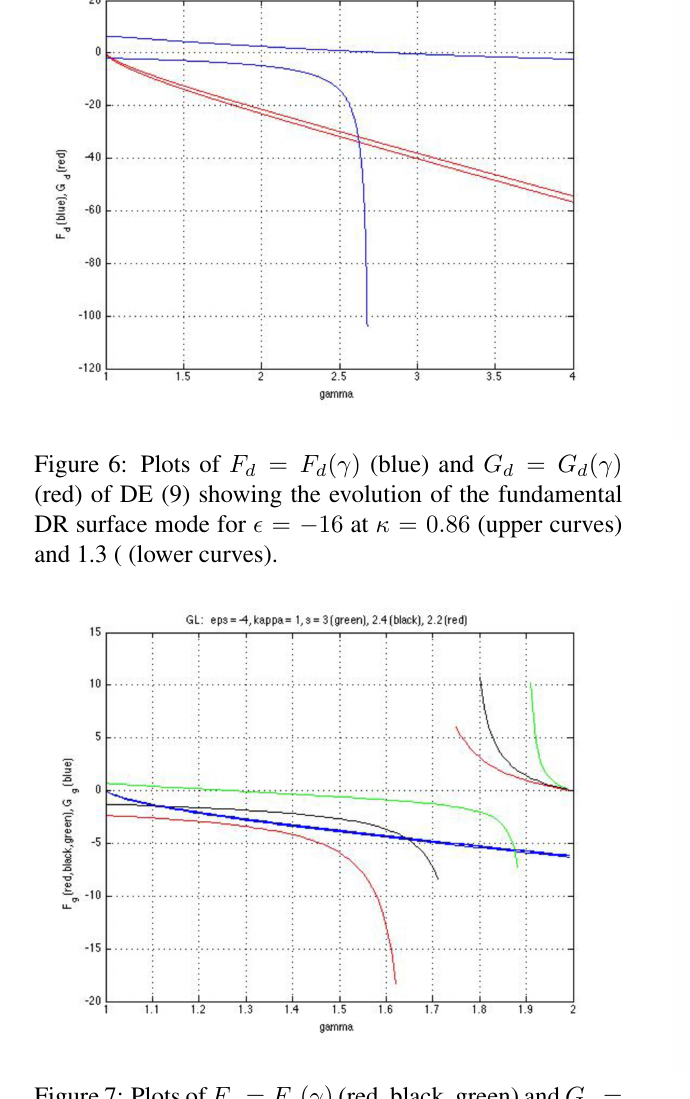
Figure 7: Plots of F g = F g ( γ ) (red, black, green) and G g = G g ( γ ) (blue) in DE (11), (12) showing the evolution of the fundamental GL surface mode for (cid:15) = − 4 , κ = 1 and s = 3 (green), 2.4 (black) and 2.2 (red).